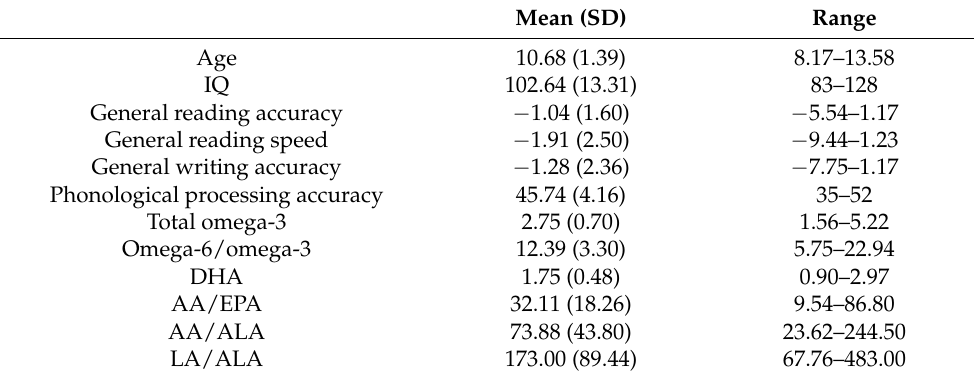
Table 1. Participants’ characteristics, performance profiles in reading/writing/phonological aware- ness, and PUFA levels. Learning measures are expressed as z-scores while PUFA levels are reported as percentages or ratios to fatty acids raw